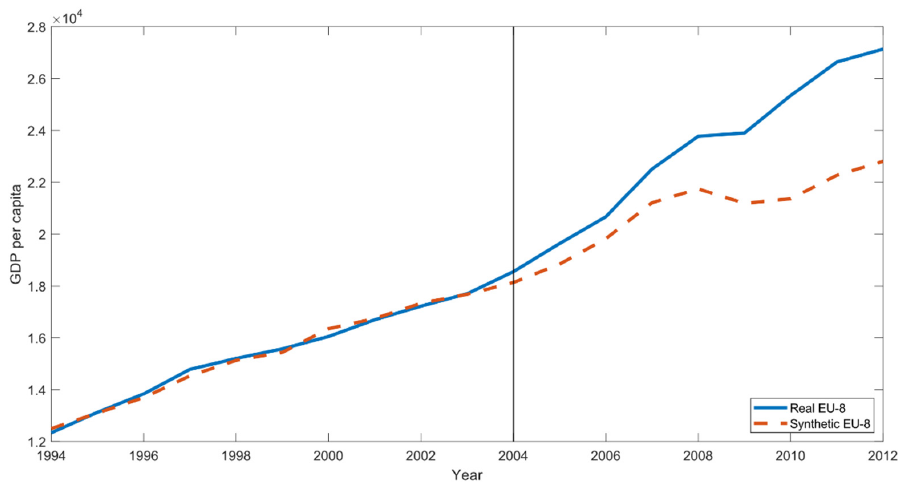
Figure 1. Trends in GDP per capita: EU-8 versus synthetic EU-8.